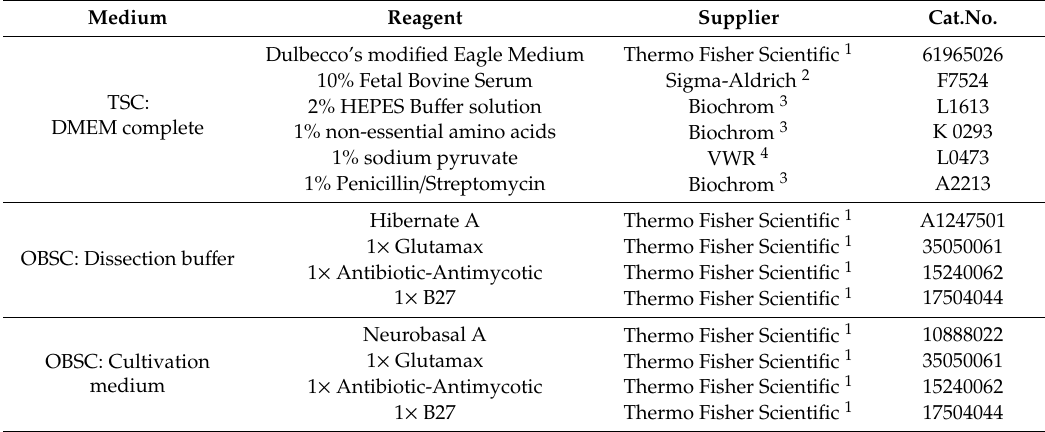
Table 1. Cell Culture Media-Reagents and their Respective